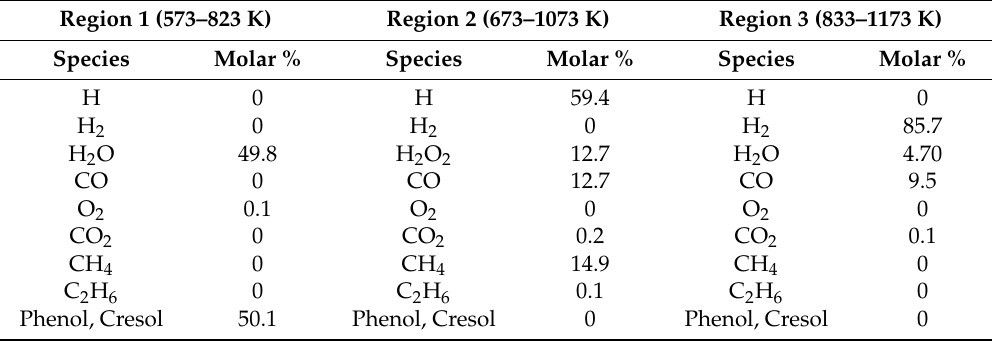
Table 3. Small molecule species produced by temperature region (from Trick and Saliba).